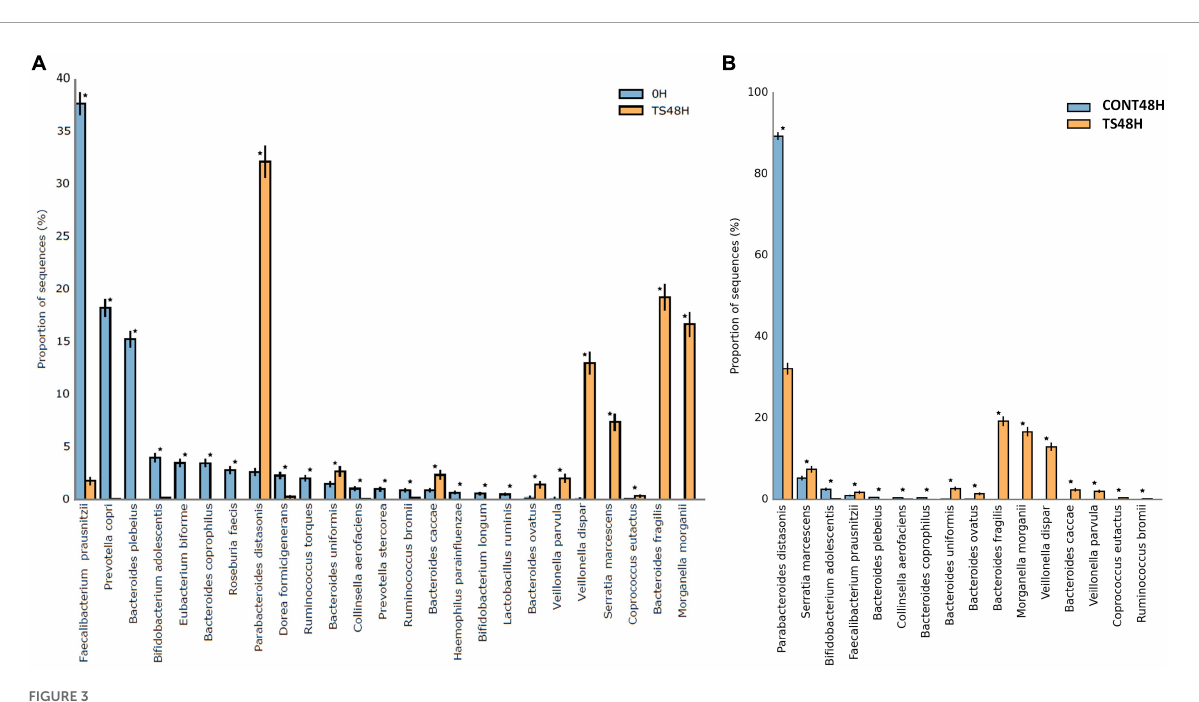
FIGURE3 Statistical differences for the more abundant identified bacterial species in Talitrus saltator -added samples at 48 h of fermentation with respect to baseline (A) and with respect to negative control samples at 48 h of fermentation (B) . CONT, Negative controls; TS, T. saltator . *Indicates significant